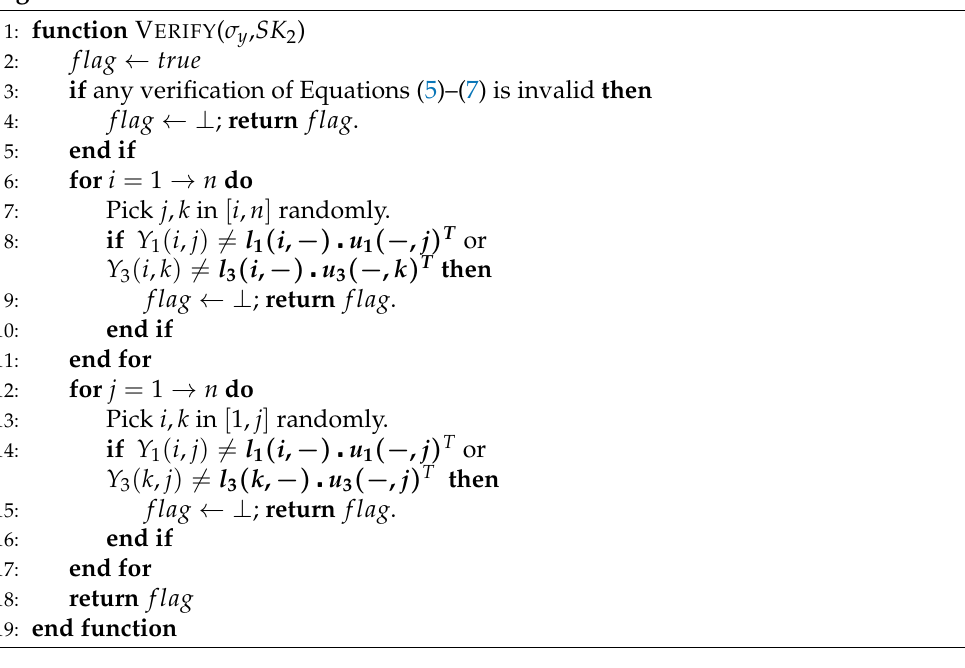
Algorithm 4 Procedure of Verification